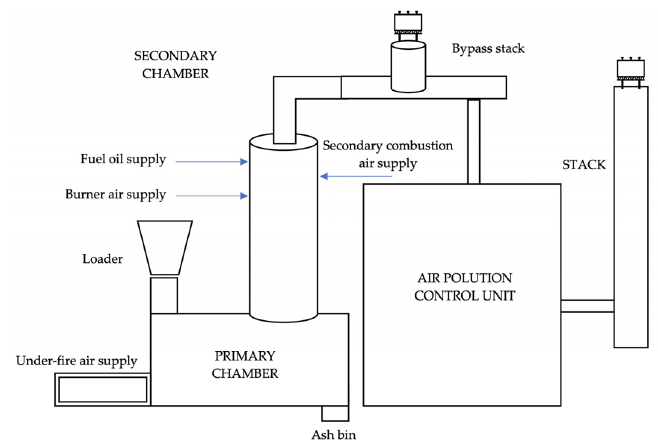
Figure 4. The schematic diagram of a clinical waste incinerator.